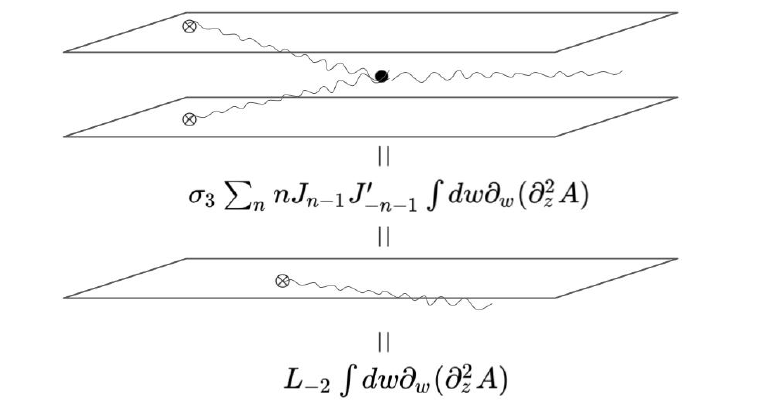
Figure 4: The top figure shows the quantum correction on the surface defect OPEs from the interaction of the two surface defects with the 5d Chern-Simons theory. The ) for the fused surface defect can be obtained by computing J J (cid:48) formula ( ∼ σ − n − 1 n − 1 3 A is L − the Feynman diagram. As the representation associated with ∂ , the OPE w 2 → ... σ J J (cid:48) directly gives the coproduct formula ∆ : L − . W ∞ , W ∞ − n − 1 n − 1 2 3